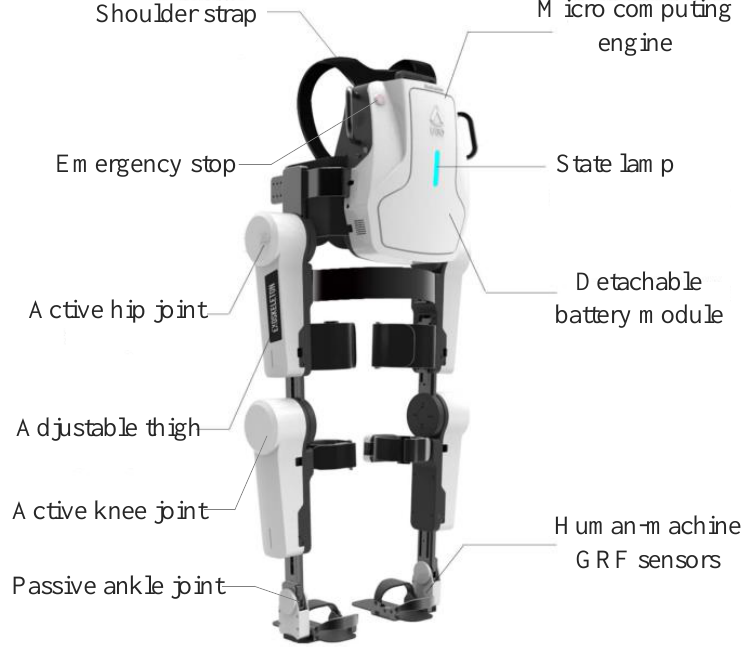
Figure 2. Lower limb exoskeleton system UGO developed by RoboCT, Inc.